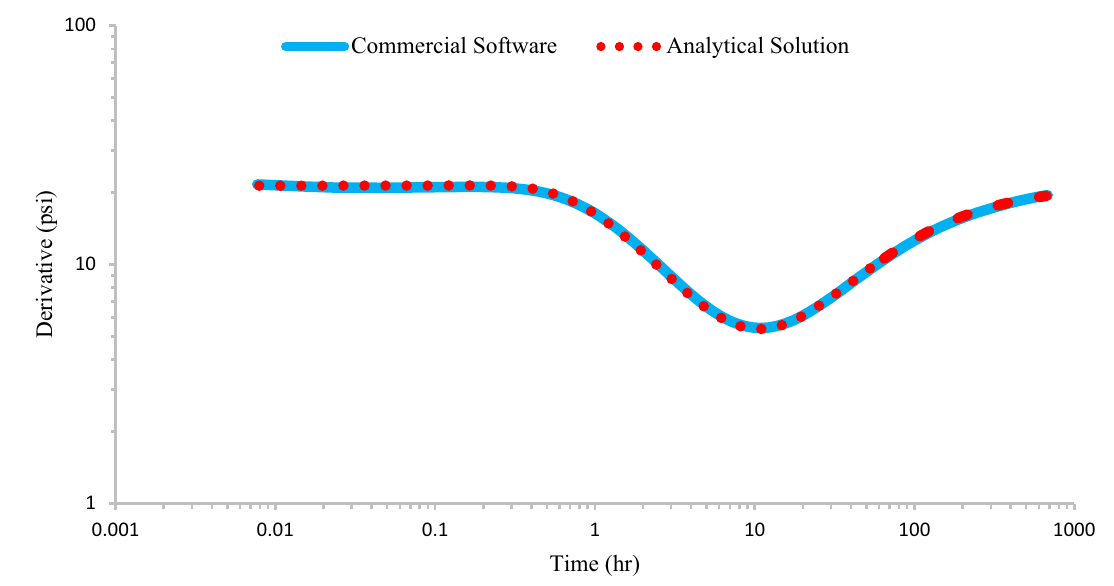
Fig. 4 Matching analytical and numerical pressure derivative plots in log–log scale of the scenario No. 1 in homogenous reservoir